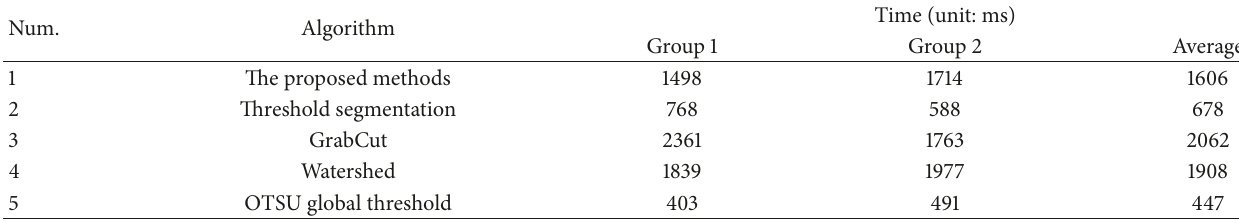
Table 1: Segmentation efficiency of different segmentation algorithms.